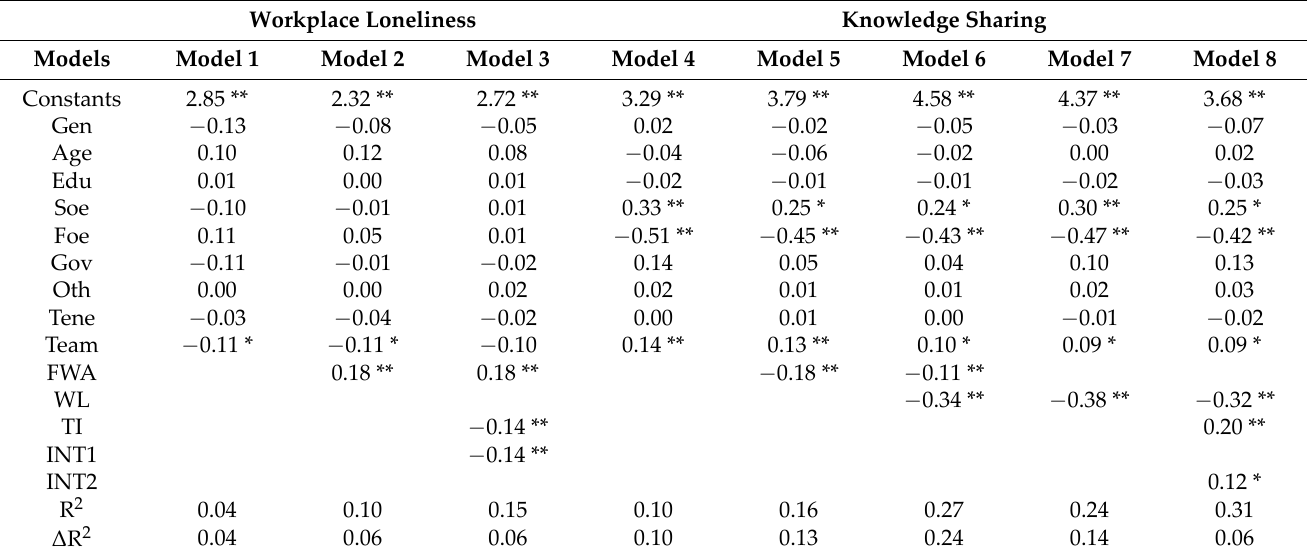
Table 2. Hierarchical regression analyses of Study 1.